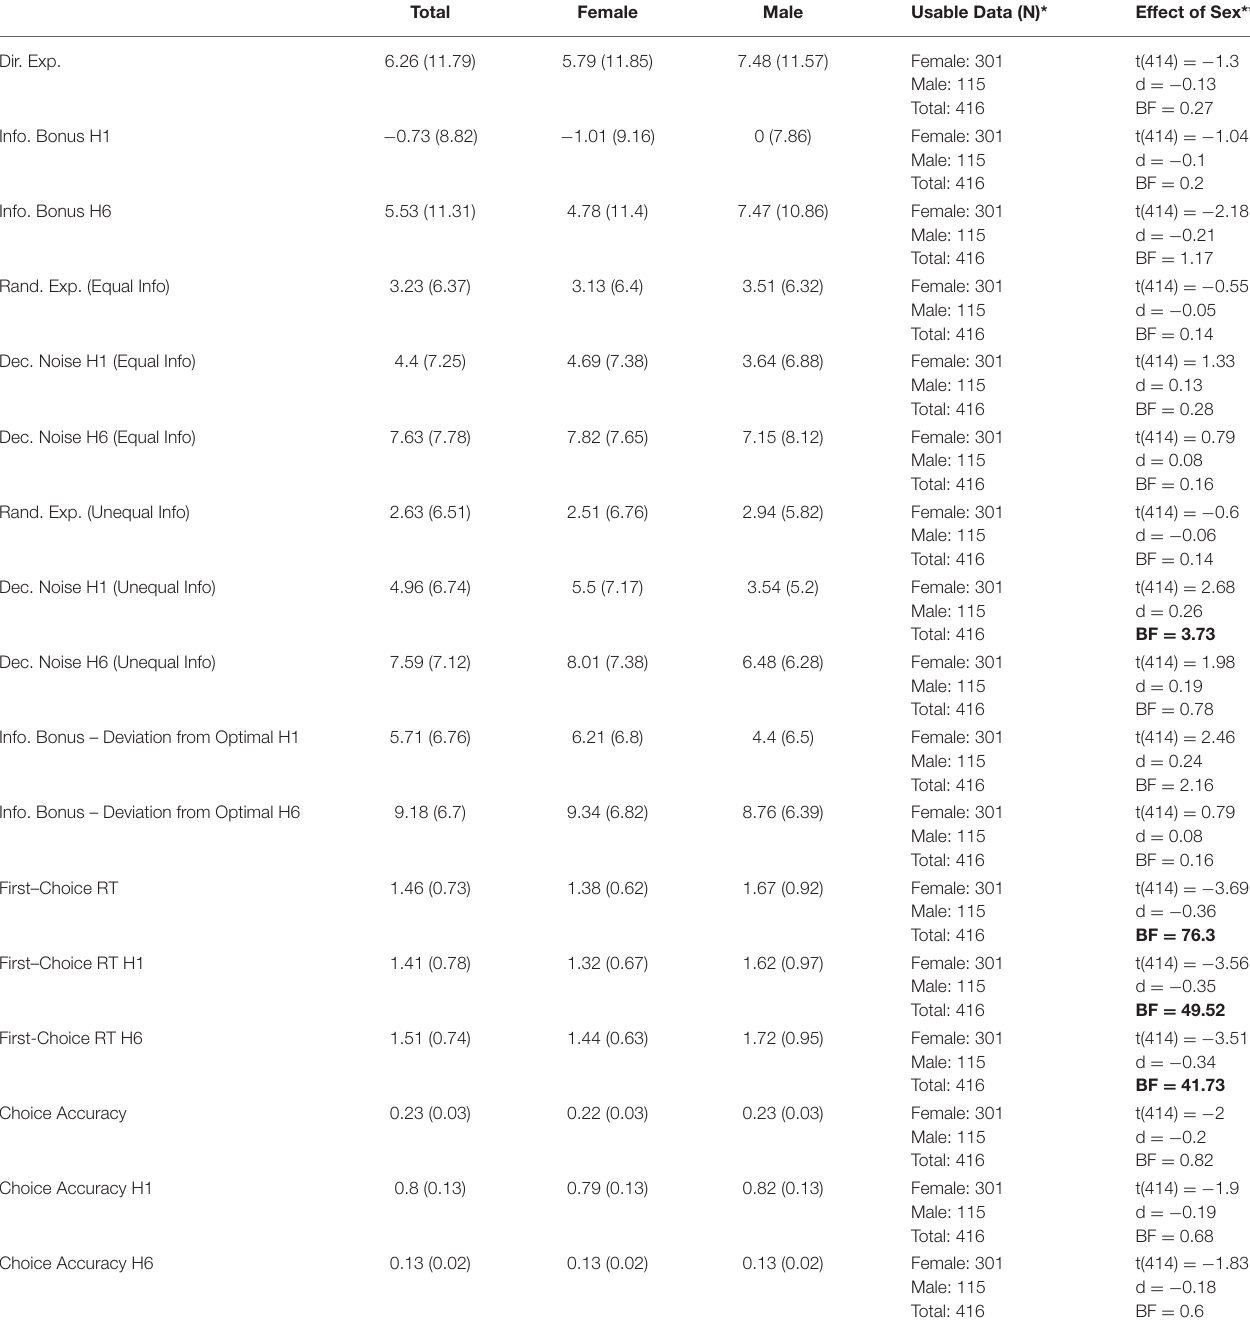
TABLE 2 | Descriptive statistics and tests of sex differences for Horizon Task variables. Total Female Usable Data (N)* Effect of